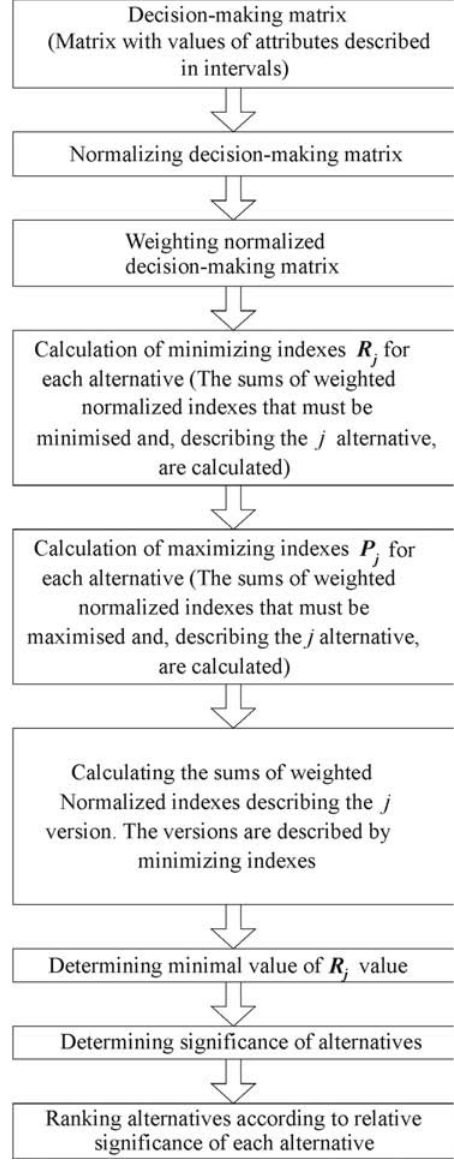
Fig. 5. Ranking of alternatives by applying COPRAS